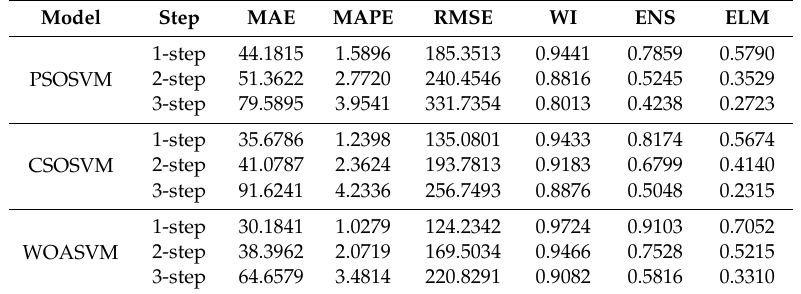
Table 2. Forecasting results of di ff erent models without EEMD using 30 min electric load data from New South Wales.